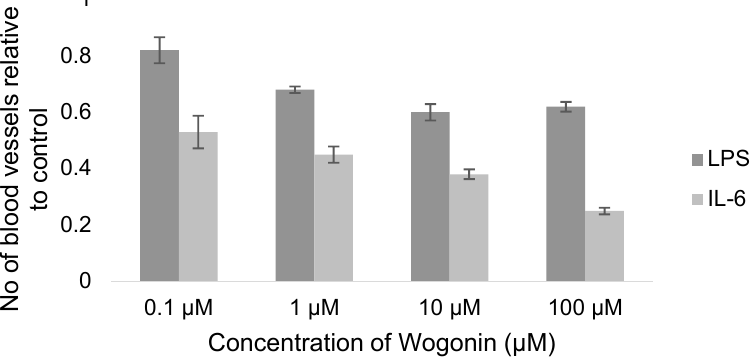
Figure 8. Reported antiangiogenic effect of wogonin on LPS and IL-6 induced angiogenesis ± SEM. Set 3: Antiangiogenic effect of flavonoids under tumor conditions